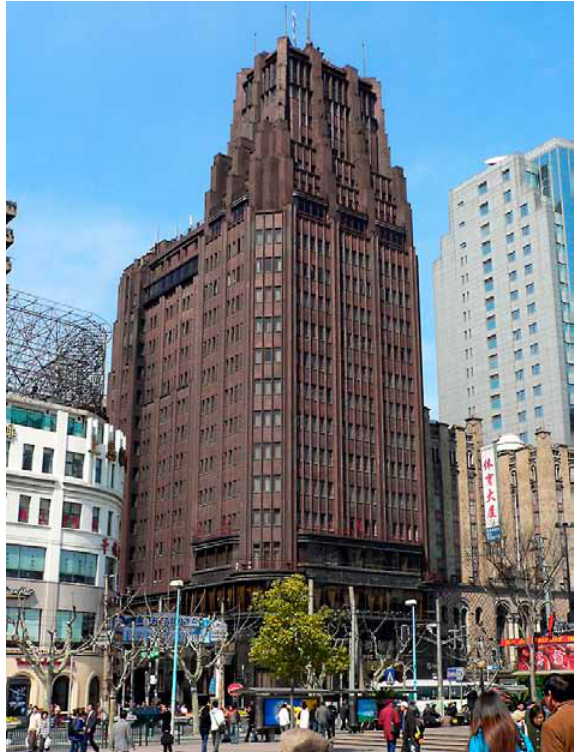
fig. 7. The Park Hotel Shanghai (1934), recent view